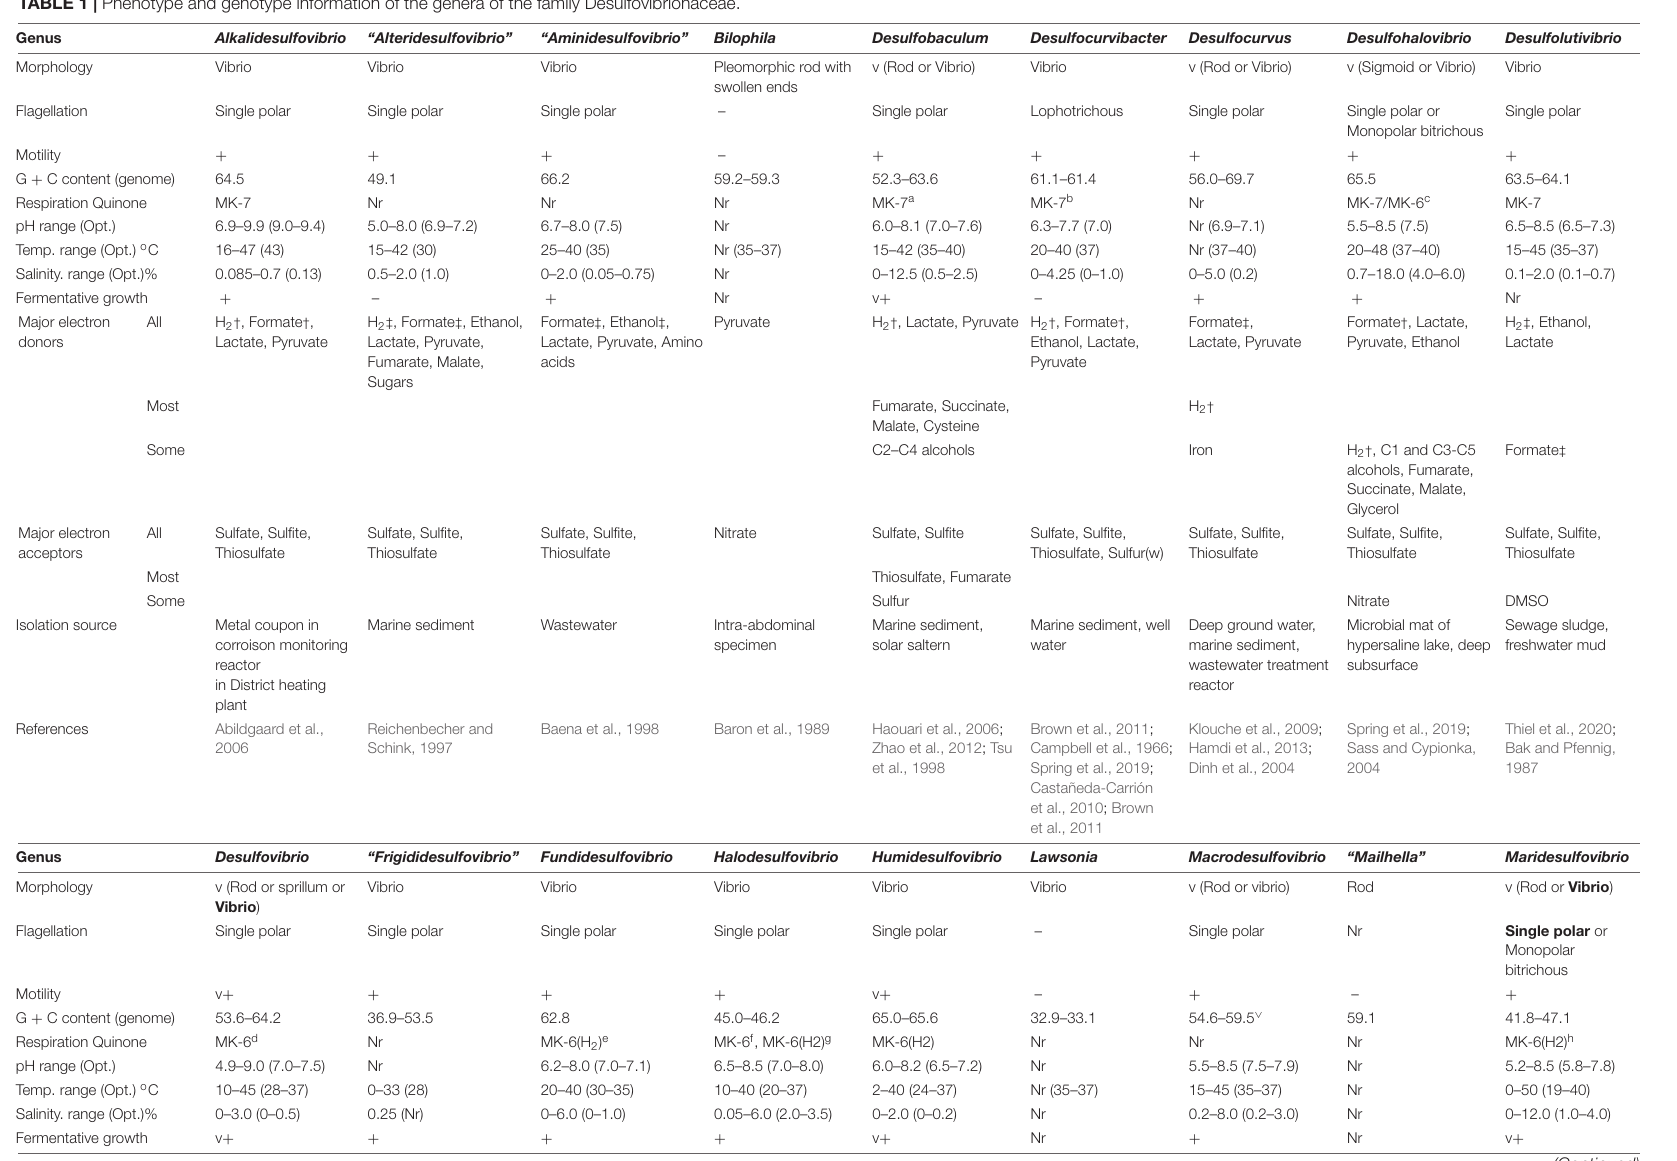
TABLE 1 | Phenotype and genotype information of the genera of the family